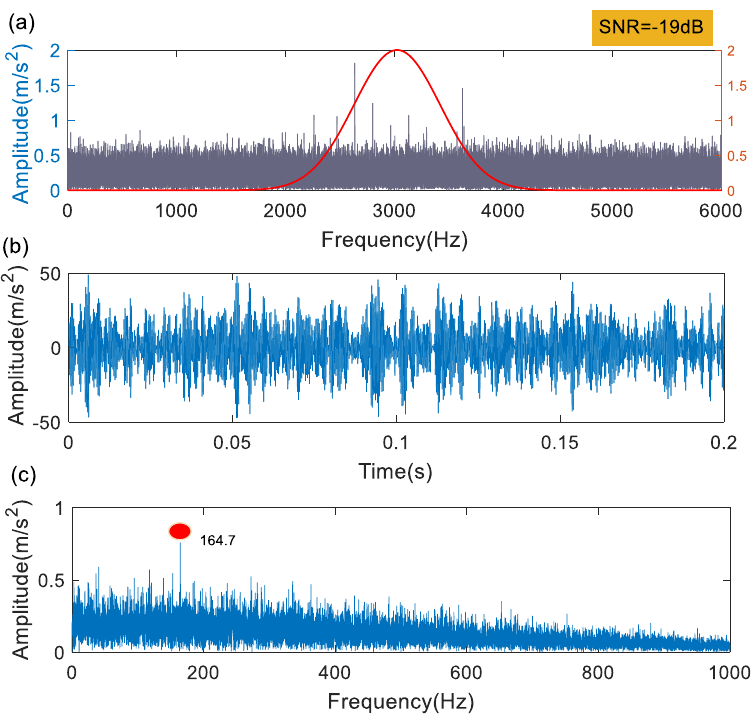
Figure 19. Results of Morlet wavelet on outer ring fault at the SNR of − 19 dB: ( a ) the signal spectrum and optimal filter; ( b ) filtered signal; ( c ) the envelope spectrum of the filtered signal.